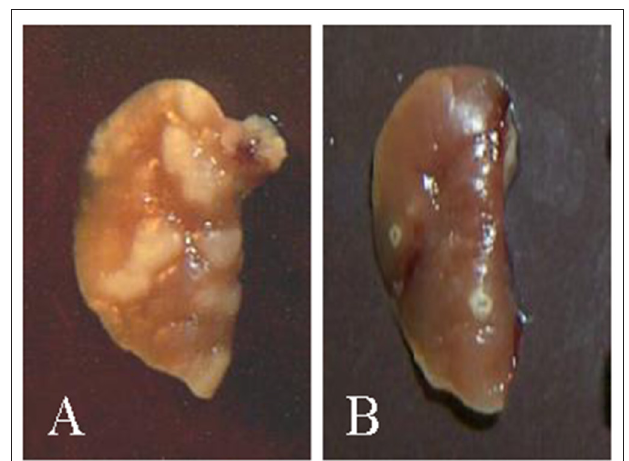
FIGURE 1 | Pictures of lungs obtained from mice at the time of necropsy (6). (A) Example of lungs from mice infected with H37rv showing granuloma lesions 3 weeks post infection. (B) Example of lungs from mice infected with the H37rv rel deletion mutant. Granulomas that developed were cleared by 3